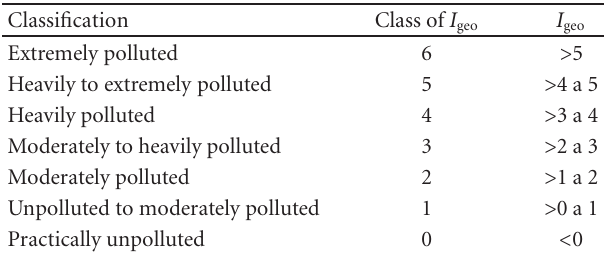
Table 3: Classification of the parameters by the geoaccumulation index, according to the degree of pollution.